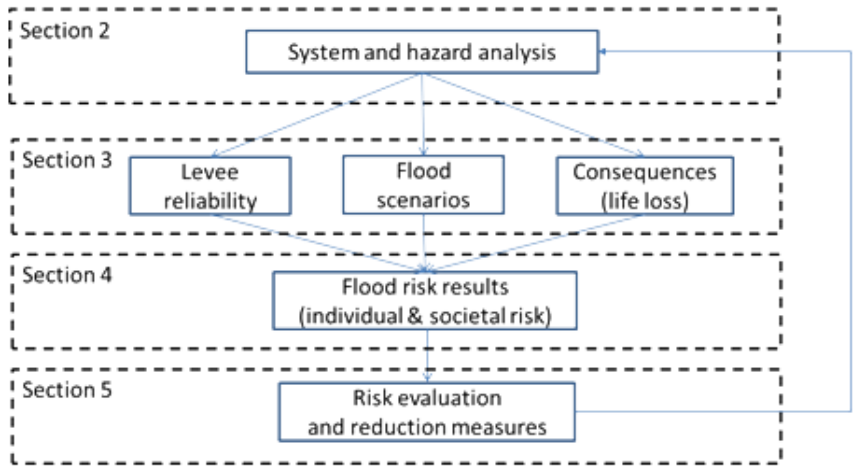
Figure 1. Steps of the flood risk analysis for New